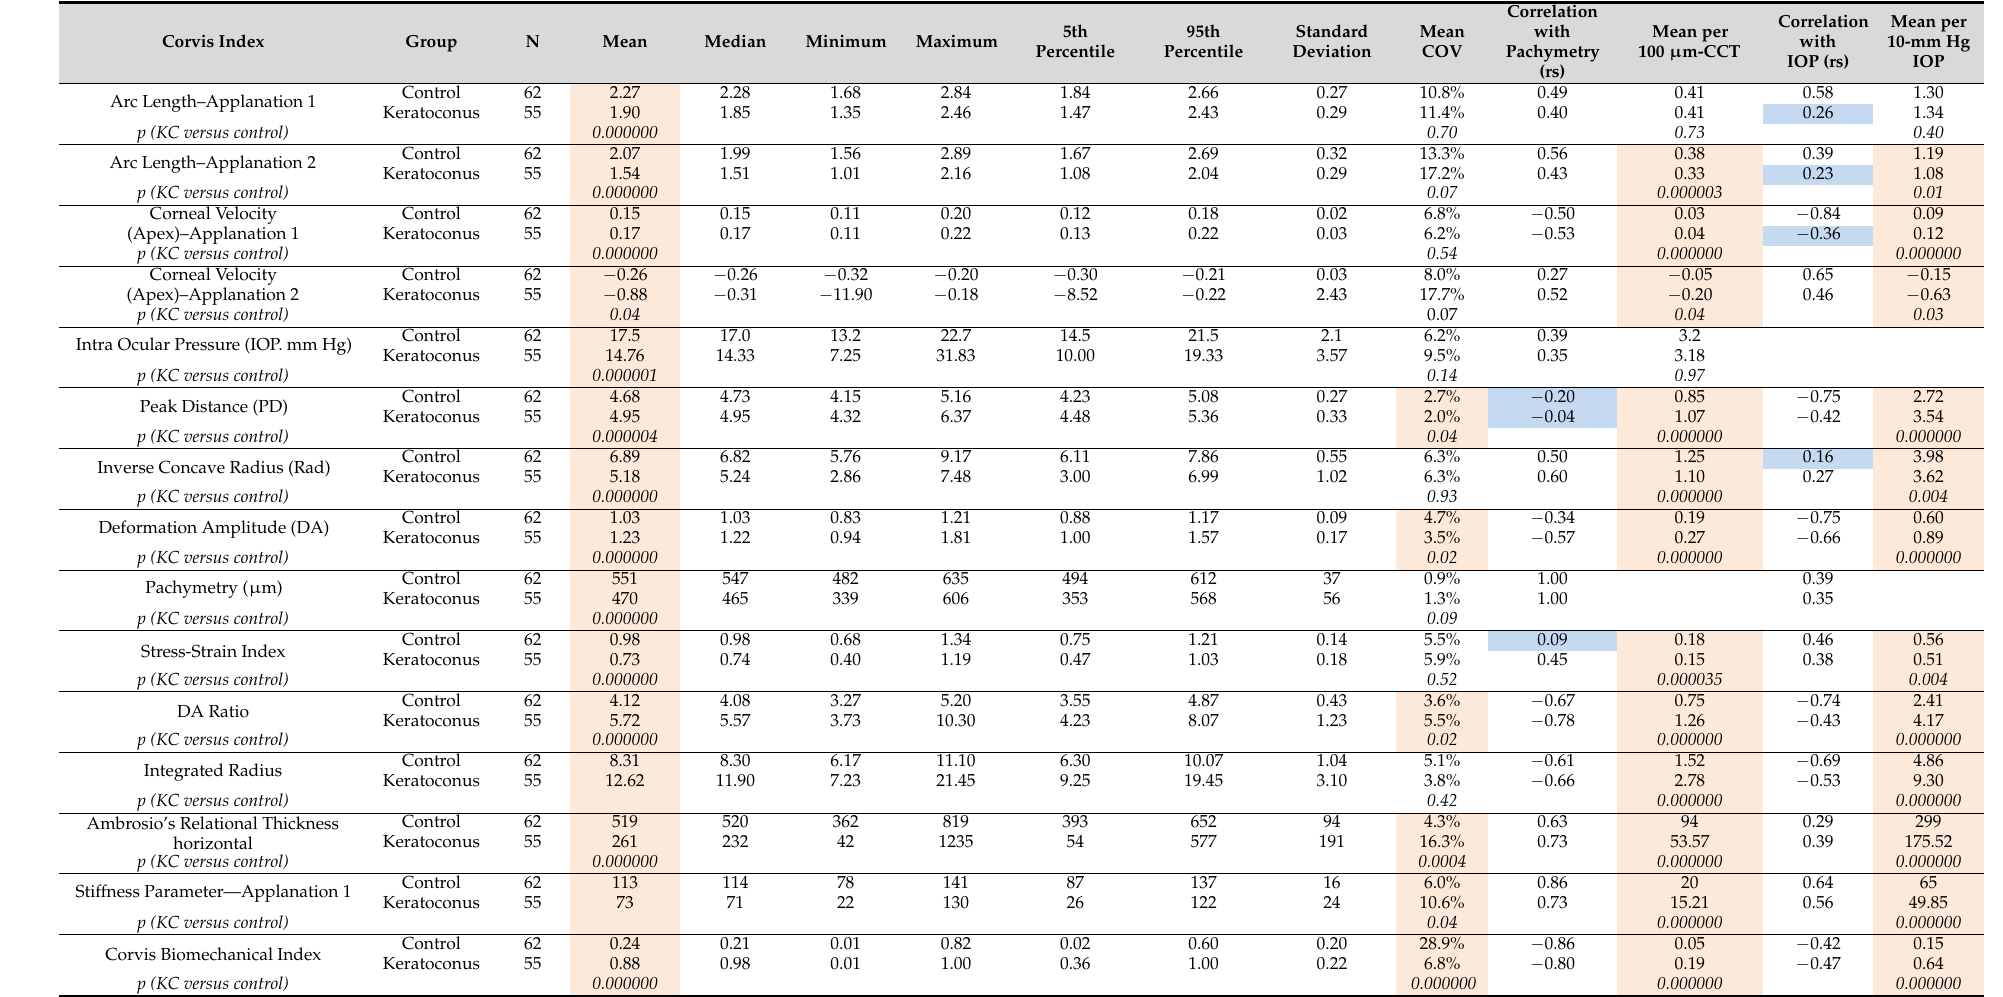
Table 1. Corvis indices in normal and keratoconus